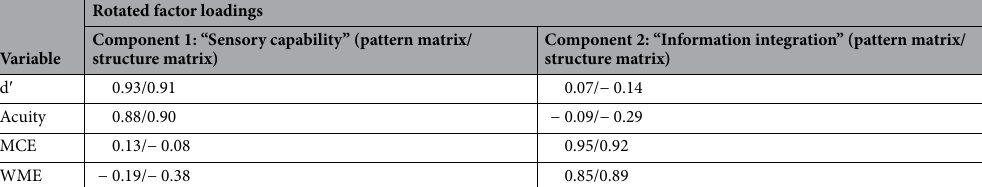
Component 2: “Information integration” (pattern matrix/ structure